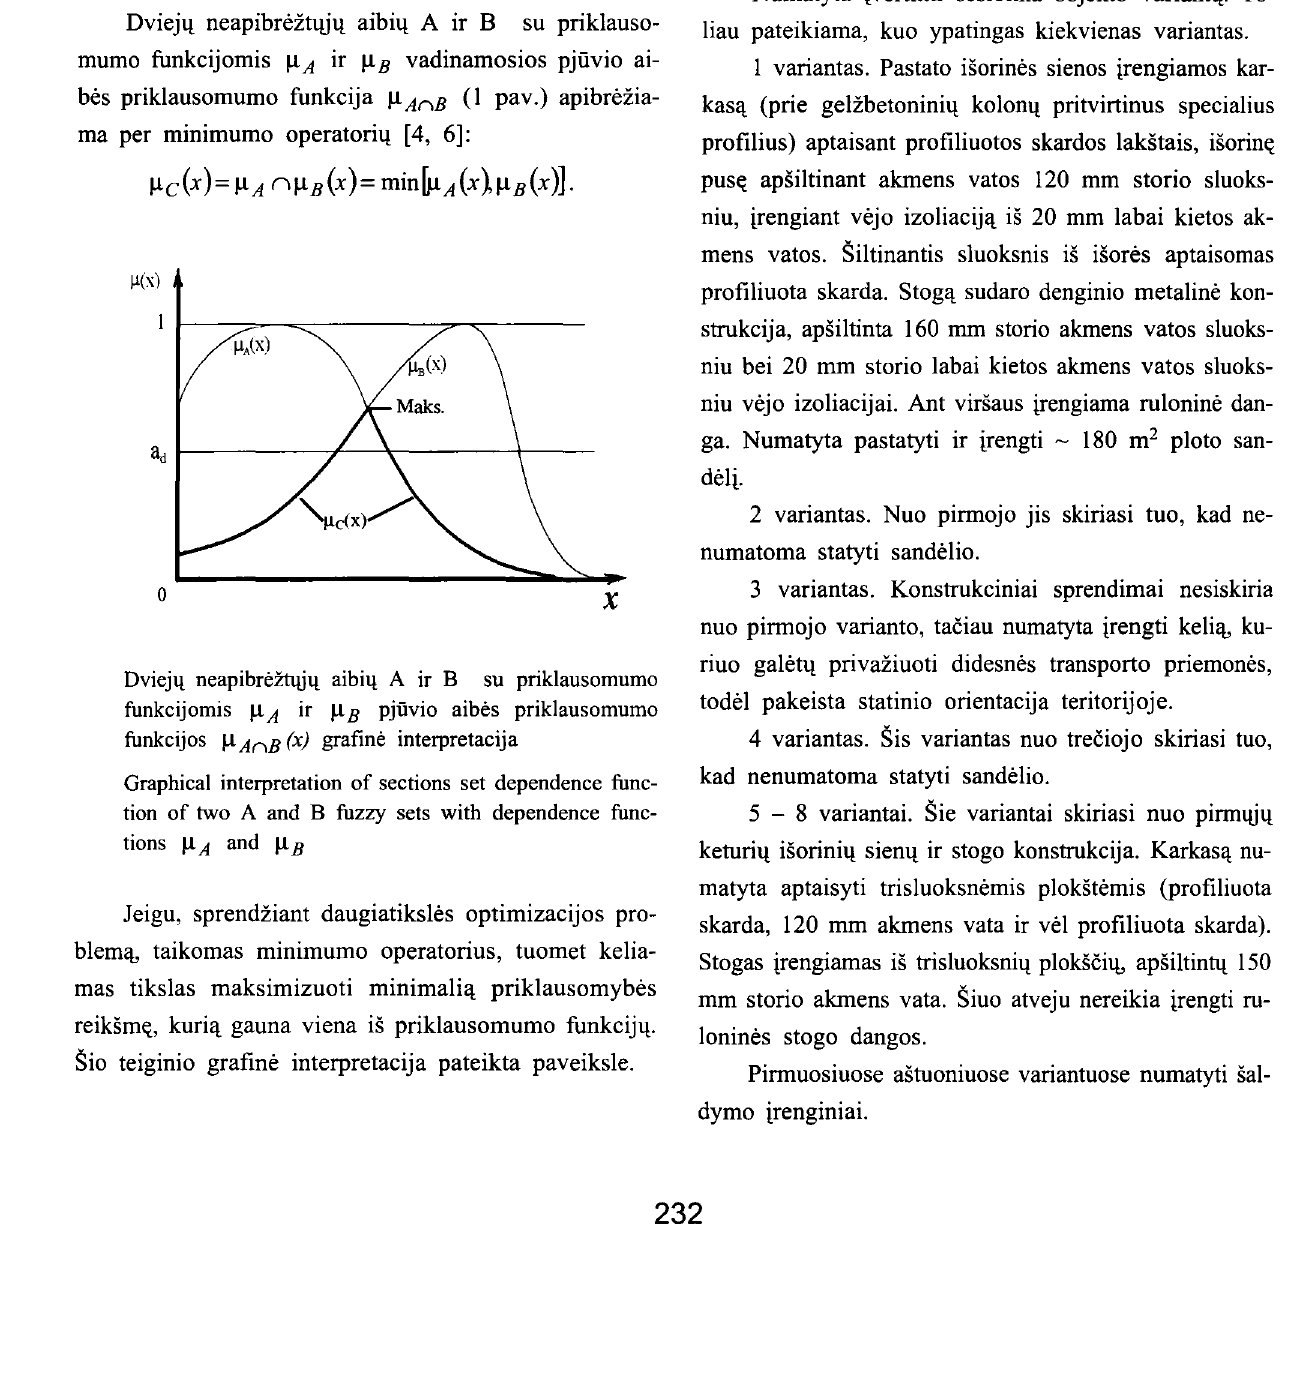
funkcijos 1.1 At1B (x) grafine interpretacija Graphical interpretation of sections set dependence func tion of two A and B fuzzy sets with dependence func tions 1.1 A and !.! B Jeigu, sprendziant daugiatiksles optimizacijos pro blem'!, taikomas minimumo operatorius, tuomet kelia mas tikslas maksimizuoti minima1il!